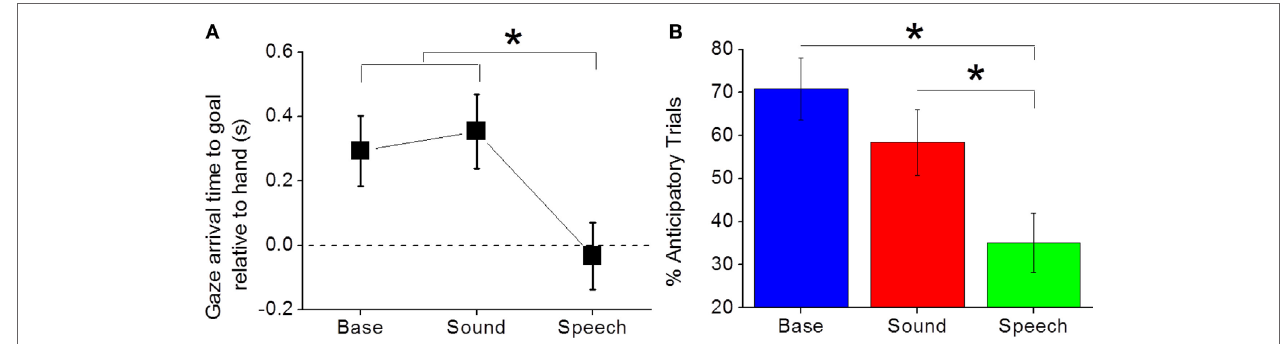
FigUre 2 | anticipatory gaze is selectively reduced by acoustic packaging the trajectory of the observed motion . (a) Anticipation, i.e., seconds between the arrival of the observer’s gaze and the arrival of the actor’s hand on the target ball in the three conditions. A positive number relates to anticipatory behavior. (B) Percentage of trials in which anticipation is larger than